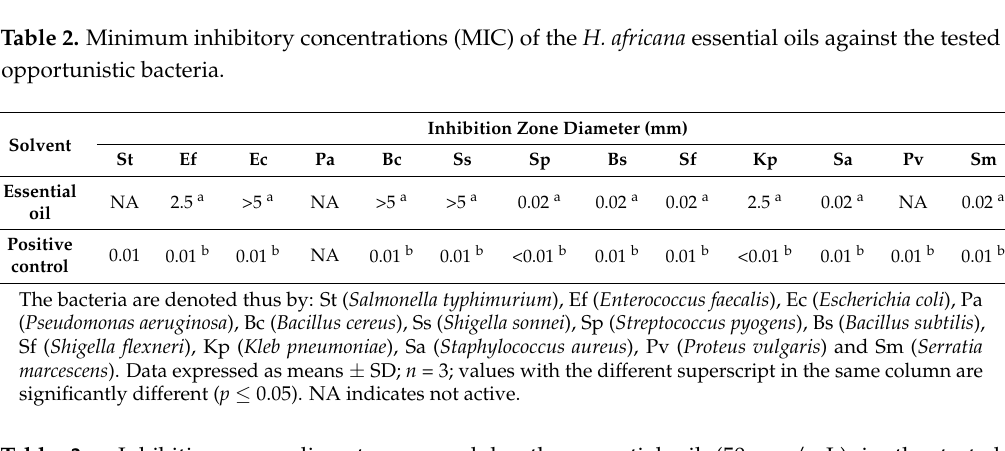
Table 3. Inhibition zone diameters caused by the essential oil (50 mg/mL) in the tested opportunistic